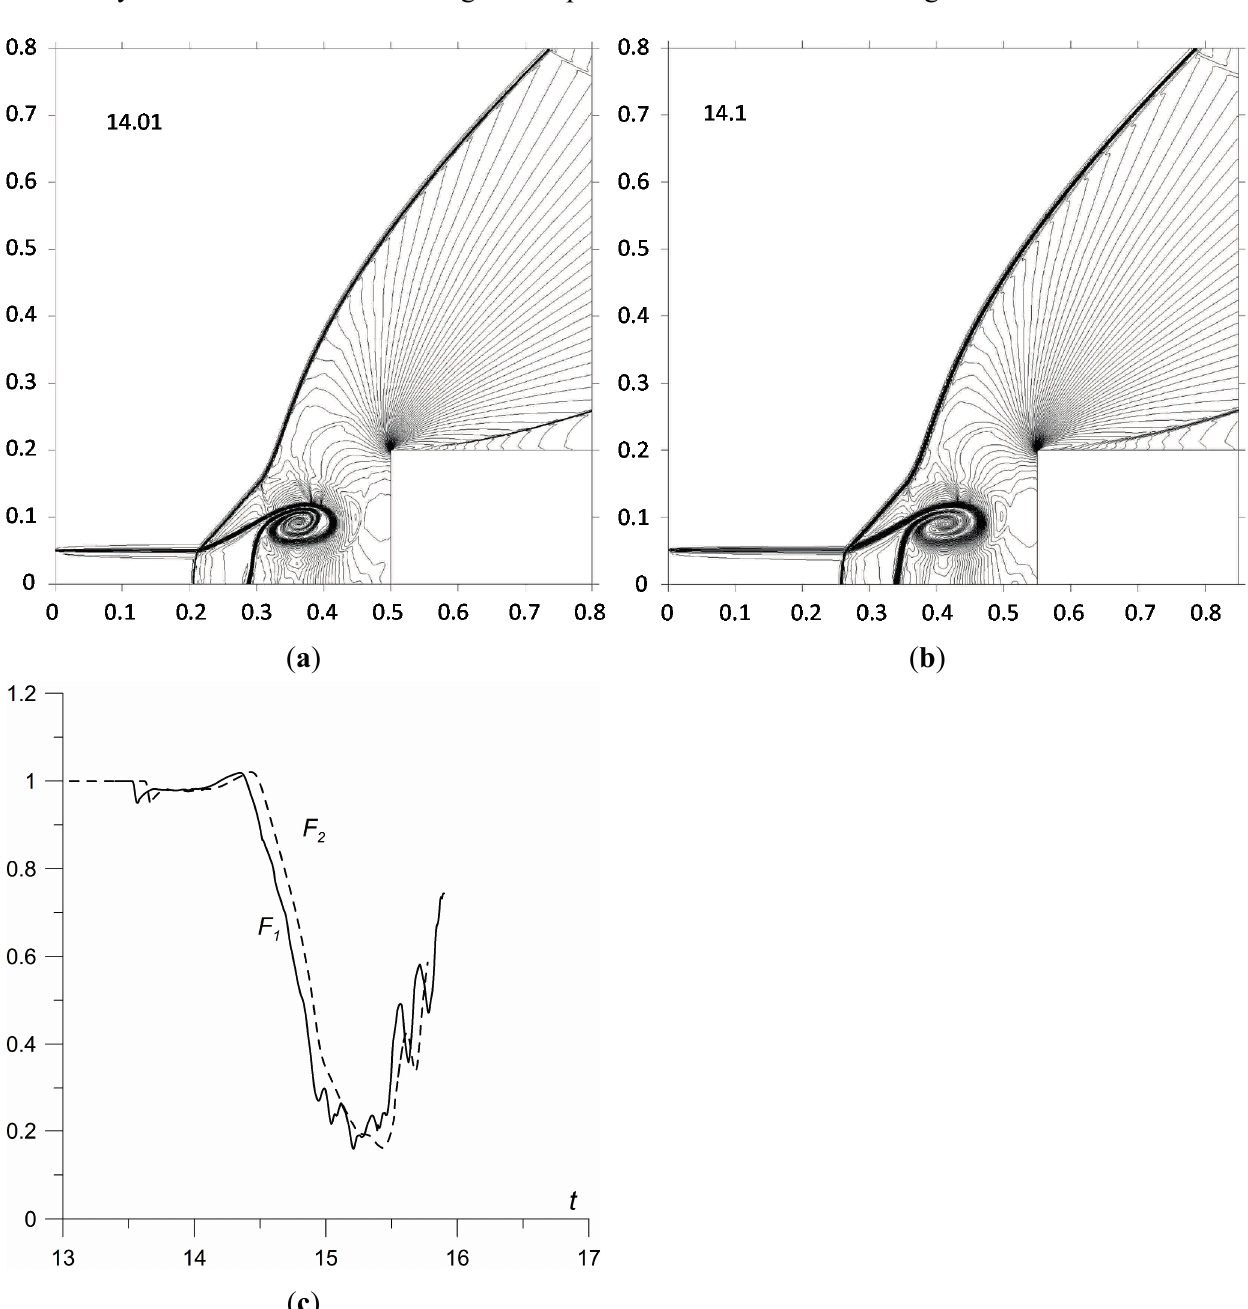
Figure 13. Density contours, t = 14.1: ( a ) Fine grid I; ( b ) Coarse grid (the body is moved on 0.05 to the right); ( c ) Front drag force dynamics: F 1 —fine grid I, F 2 — coarse grid; α ρ =